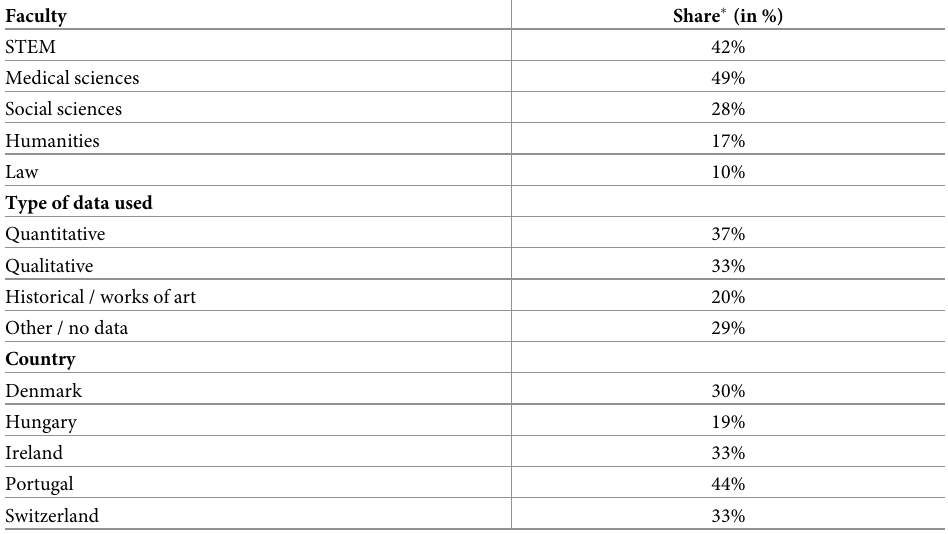
Table 7. Share of PhD students that believe they have granted at least one guest authorship to a person in power per faculty, country, and type of data used ( n = 1,096).